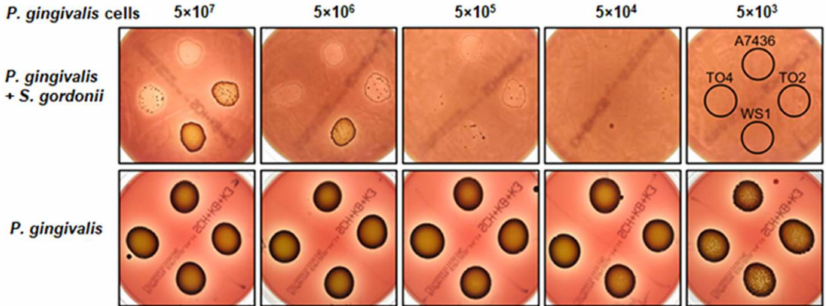
Figure 10. Two-species biofilm formation. S. gordonii was grown on blood agar plates for 24 h under an increased concentration of CO 2 . Then, the indicated number of P. gingivalis cells was applied on and the growth of P. gingivalis wild type strain (A7436) or ∆ hmuY (TO4), ∆ hmuR (WS1), ∆ hmuY ∆ hmuR (TO2) mutant strains alone (bottom panel) or as co-cultures with S. gordonii (top panel) was examined under anaerobic conditions. Biofilm formation and pigmentation were visually